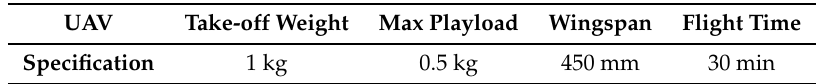
Figure 3. Attitude sensors data corrected commercial autopilot platform. Table 1. The UAV specifications.